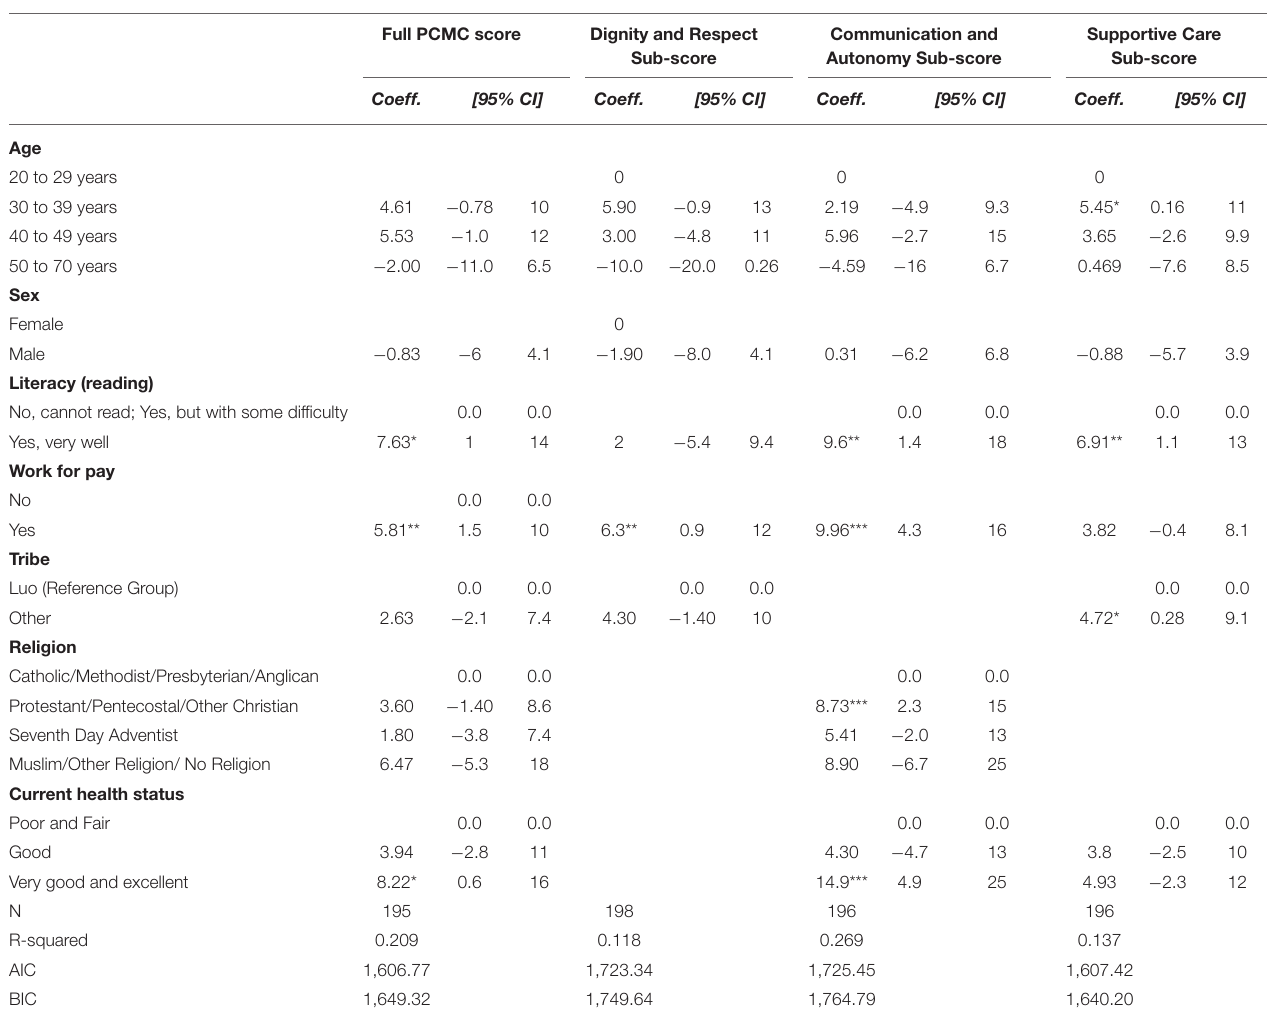
TABLE 4 | Multivariate linear regression analysis of select predictors on the full PCMC and sub-scale